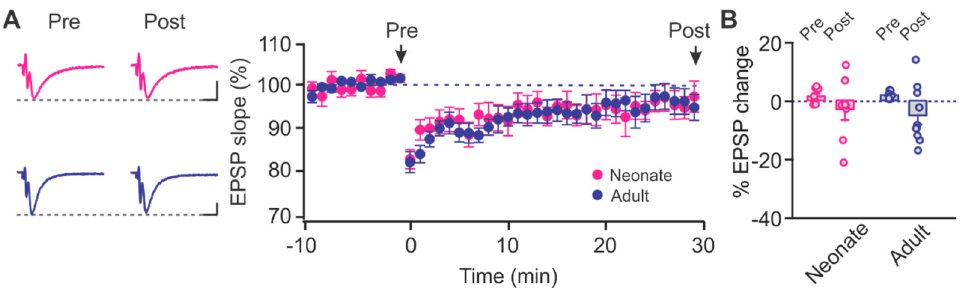
Figure 7. The role of GluN2B in age-dependent LTD in the piriform layer Ib. ( A ) Example traces and time courses of fEPSPs with LTD inductions in the presence of Ro25-6981 (1 µM) in neonate and adult rats. Scale bars, 0.5 mV, 5 msec. ( B ) % changes of fEPSPs at 30 min post-LTD induction. Neonate: n = 8; Adult: n = 9.